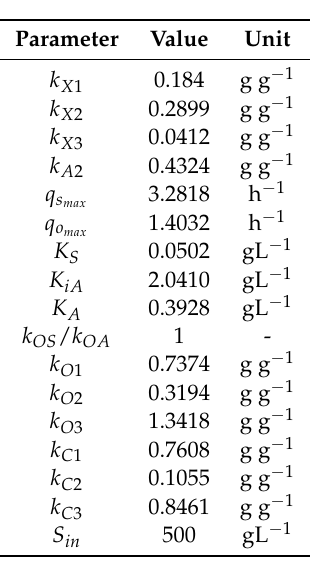
Table 4. Numerical values of the E. coli fed-batch model parameters (as in